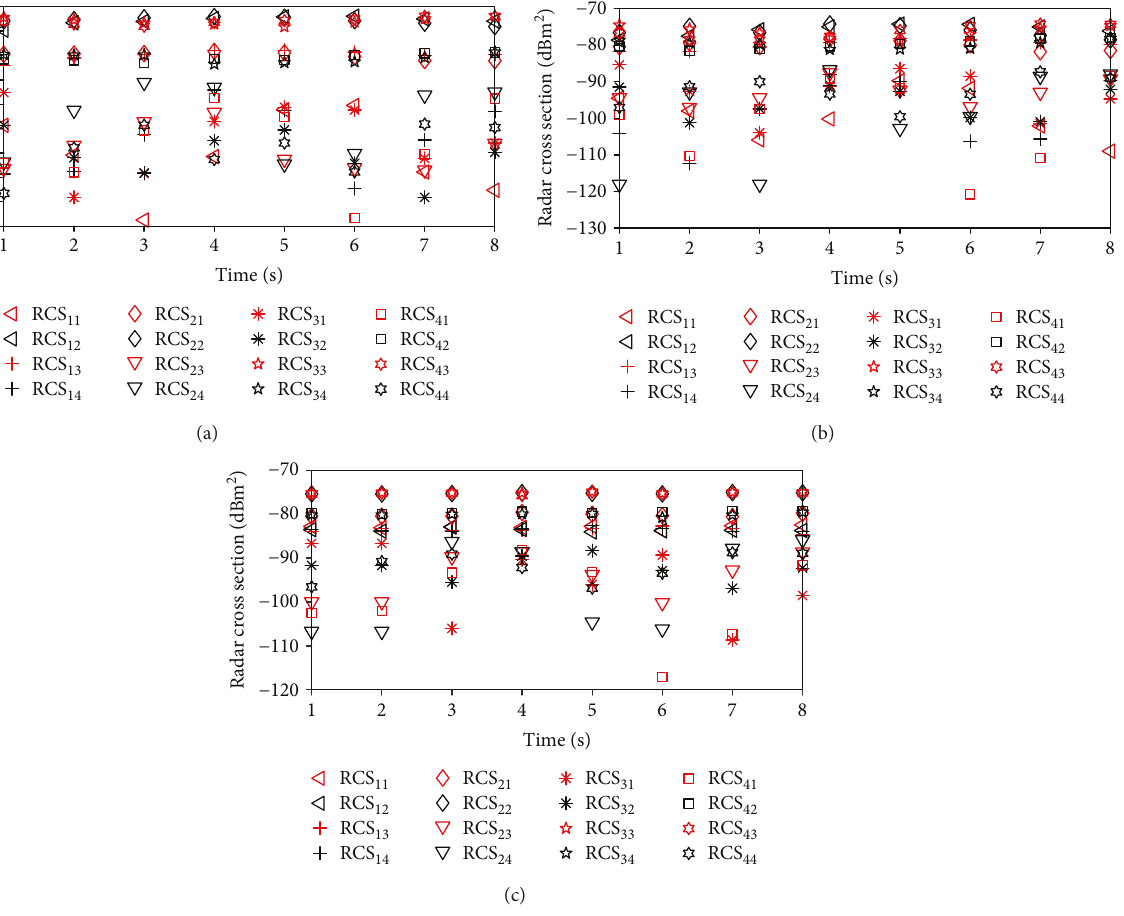
Figure 6: RCS simulation results of horizontally orientated (a) hexagonal columns, (b) ellipsoids, and (c) spheres by means of